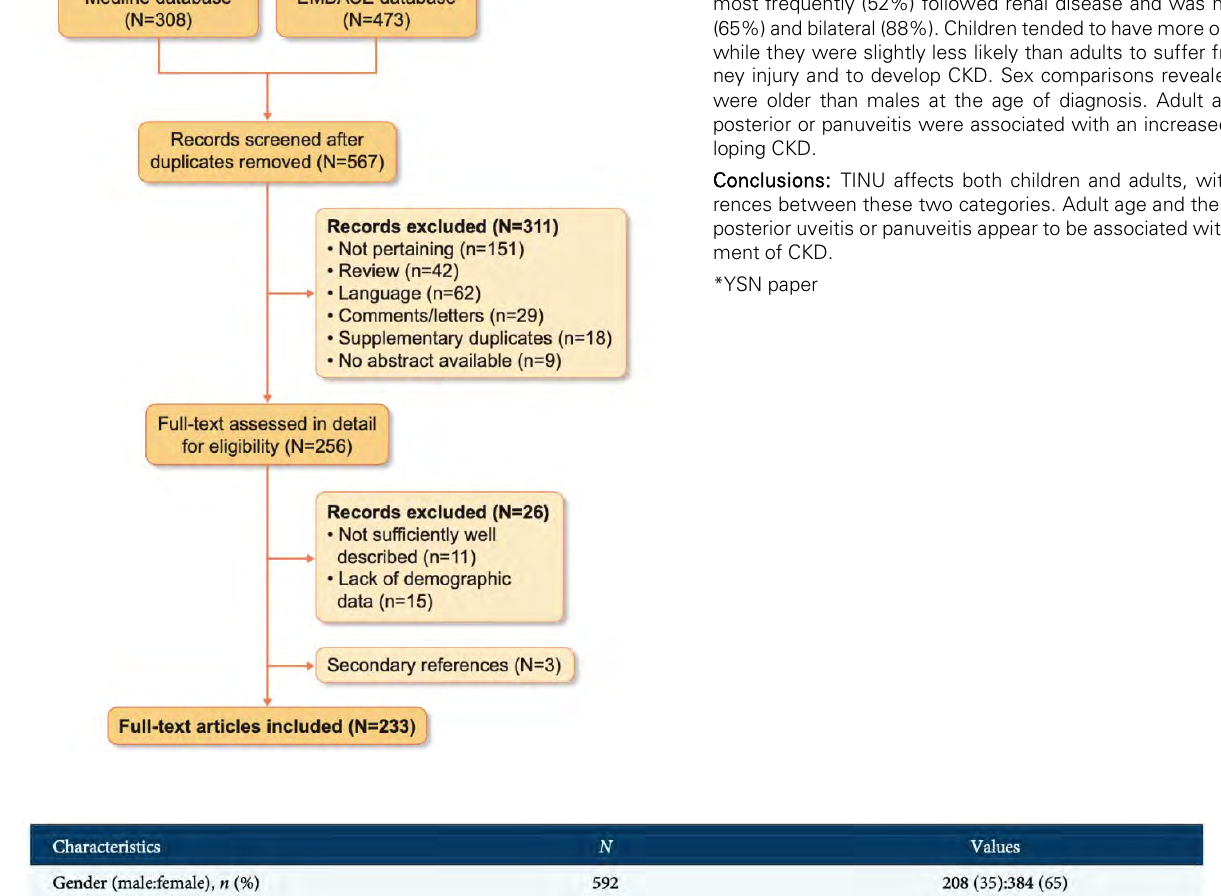
Results: A total of 233 articles reporting 592 TINU cases were retained for the analysis. The median age of the included subjects was 17 years (interquartile range 13–46) with a female pre- dominance (65%). Uveitis most frequently (52%) followed renal disease and was mostly anterior (65%) and bilateral (88%). Children tended to have more ocular relapses, while they were slightly less likely than adults to suffer from acute kid- ney injury and to develop CKD. Sex comparisons revealed that female were older than males at the age of diagnosis. Adult age as well as posterior or panuveitis were associated with an increased risk of deve- loping CKD. Conclusions: TINU affects both children and adults, with some diffe- rences between these two categories. Adult age and the presence of a posterior uveitis or panuveitis appear to be associated with the develop- ment of